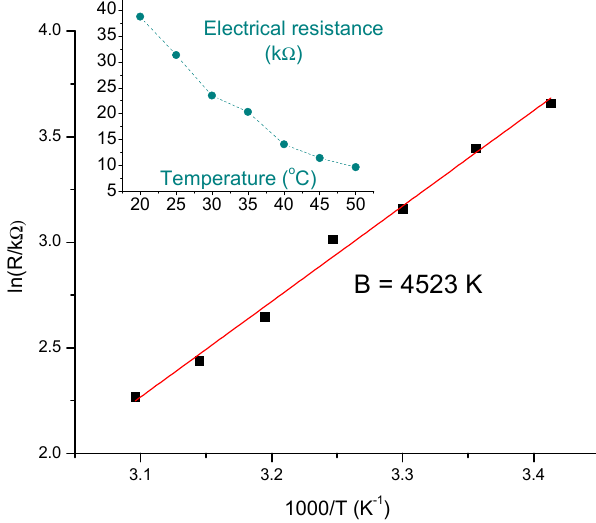
Figure 7. Fitting of the material constant (B) from the measured DC electrical resistance of NiMn 2 O 4 - alginate nano-biocomposite film shown in the inset using Equation (1).